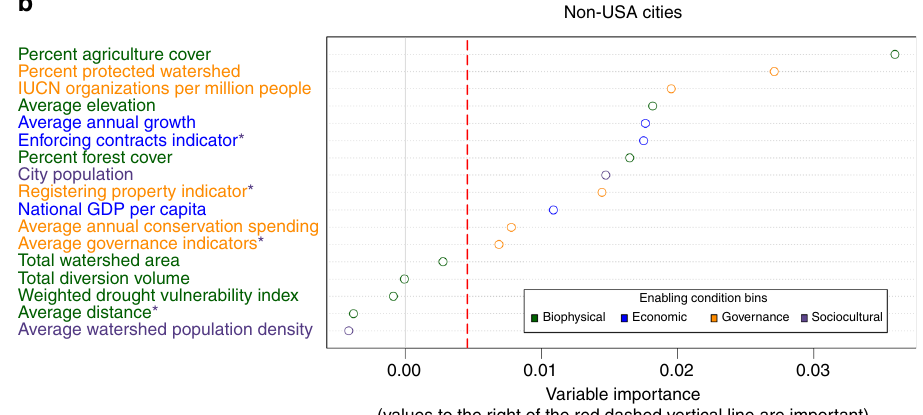
Fig. 3 Relative ranked importance of enabling conditions variables. These are categorized in four main bins for a Global Cities, n = 416, and b Non-USA Cities, n = 299. Variables with an asterix could also be considered representative of enabling conditions in the sociocultural bin (see Supplementary Data 1 for relationship between representative data and enabling conditions). Variable Importance measures are a relative ranking of predictor variables, thus the absolute numbers on the X-axis do not have meaning outside of comparisons between predictor variable values. Values to the right of the red dashed vertical line are considered important in the model and those with higher variable importance values are more important than other variables with lower variable importance